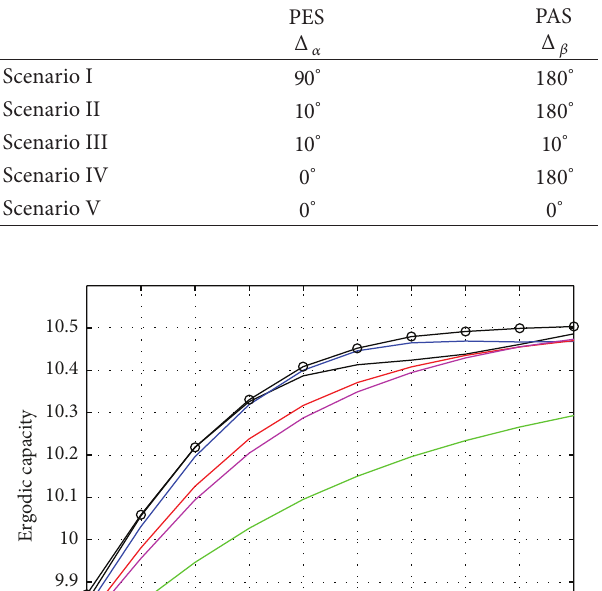
Table 1: PAS and PES for different propagation scenarios.